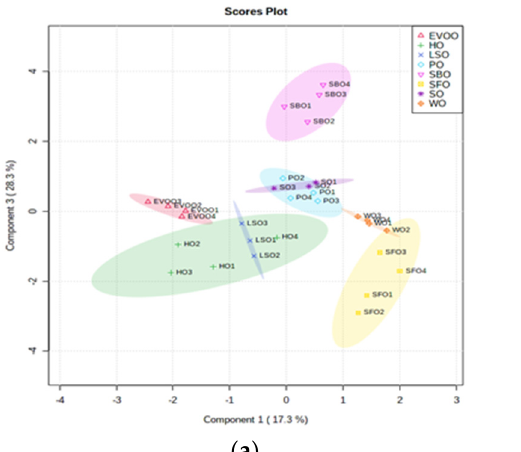
Table 2. Mean values and standard deviations (x ± SD) representing the percentages of saturated (SFA), monounsaturated (MUFA), polyunsaturated (PUFA) fatty acids identified in each type of oil. The ratios PUFA/MUFA and MUFA+PUFA/SFA (unsaturation index) are presented in columns 5 and 6, respectively. For oil abbreviations, see Table 1.